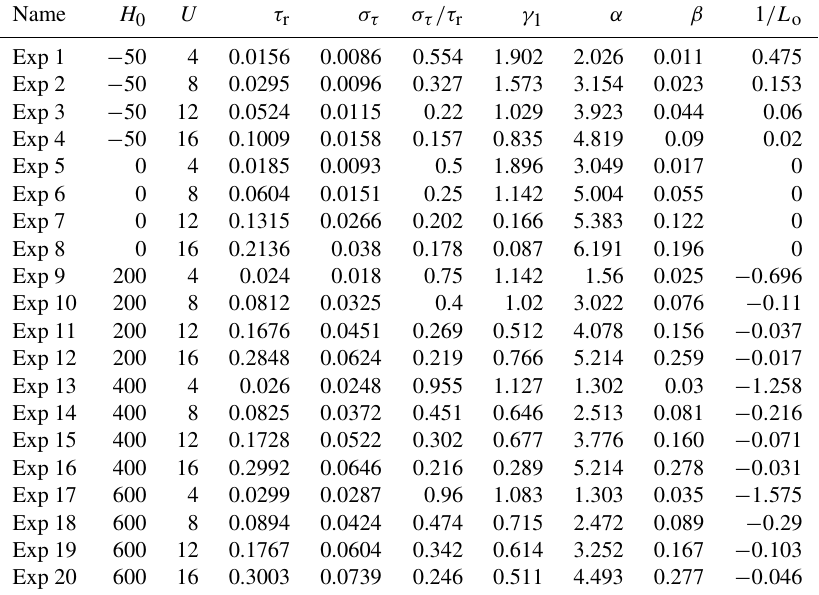
Figure 2. Time evolution of deposition velocity V d at grid point n x = 198, n y = 41 when H 0 = 600Wm − 2 , z 0 = 0 . 153mm and (a) U = 4ms − 1 and (b) U = 16ms − 1 . RE = the standard deviation of simulated instantaneous deposition velocity V d and mean deposition velocity, V d , LES . Table 2. Statistics of shear stress for numerical experiments Exp